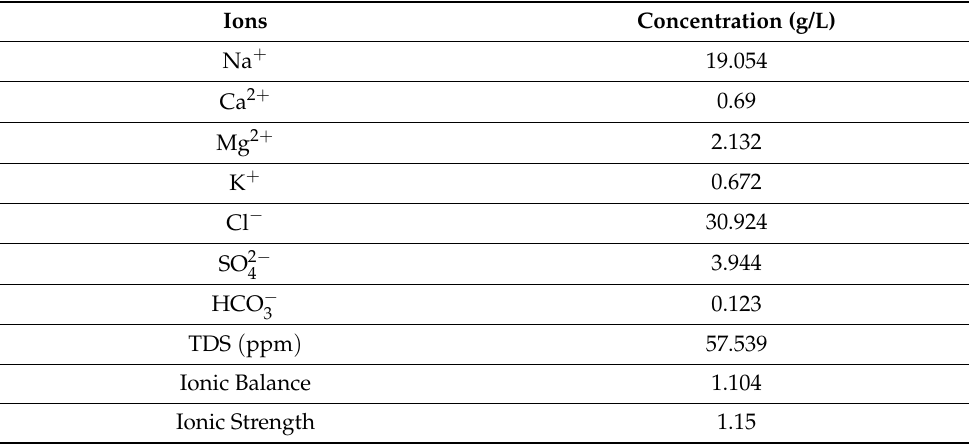
Table 2. Concentration of ions of